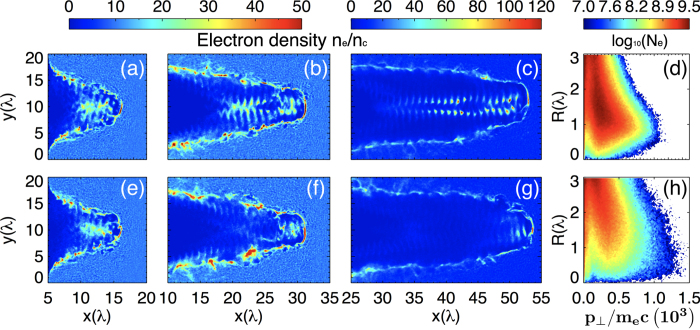
Density maps (in units of nc) of electrons in the plane z = 0 at t = 30T0 [(a) and (e)], 60T0 [(b) and (f)], 80T0 [(c) and (g)] for a CP laser pulse at intensity 1.9 × 1023 W/cm2 interaction with plasmas at densities 10nc in the cases with (upper row) and without (lower row) the QED effects taken into account, respectively. (d) and (h) show the corresponding transverse phase space distributions of electrons at 80T0.